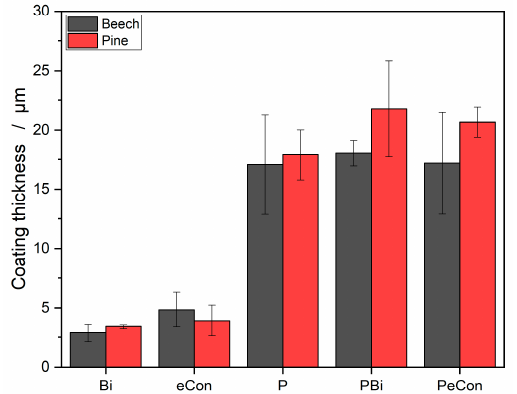
Figure 1. Coating thickness of metal oxide, polyester and coating system (CS) layer ( n = 5).